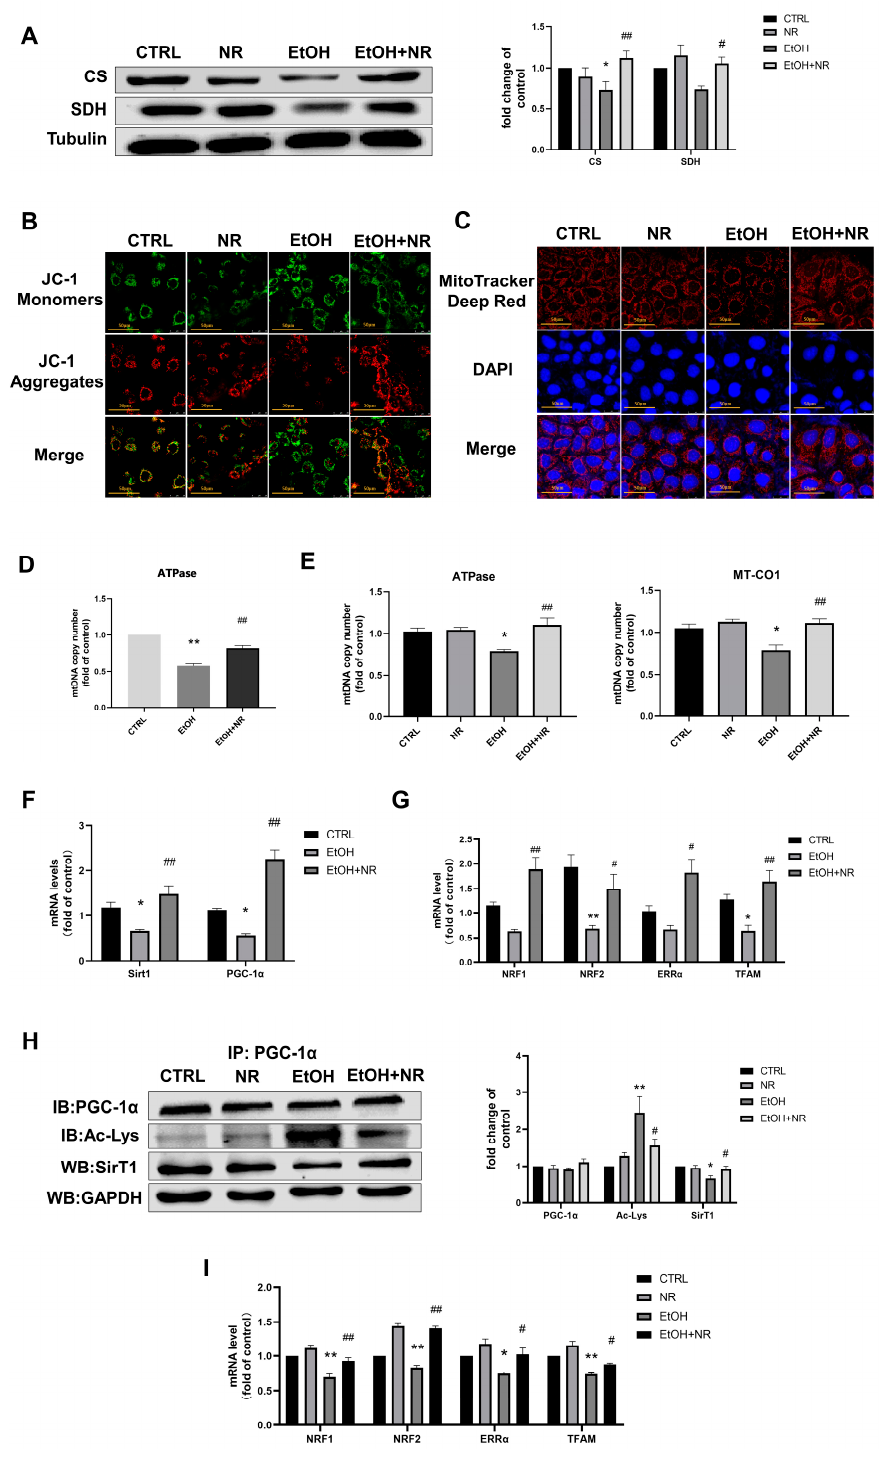
Figure 3. NR restores ethanol-induced intestinal mitochondrial dysfunctions both in in vivo and in vitro experiments. ( A ) The representative image and quantification of Western blot analysis of CS and SDH protein expressions in Caco-2 cells. Tubulin was used as an internal control. Results